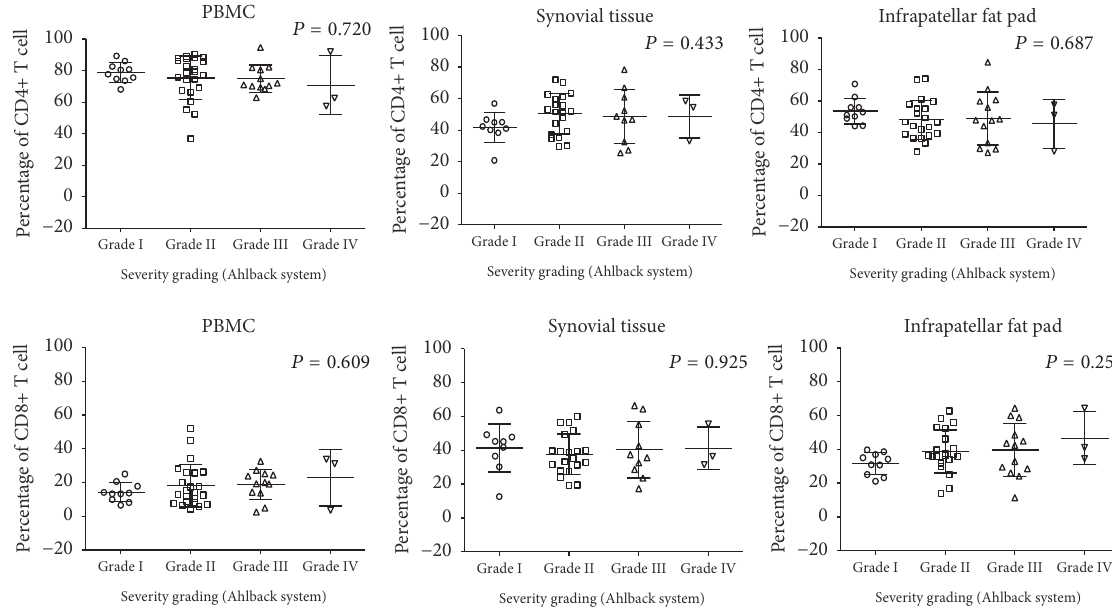
Figure 2: Frequency of CD4 + and CD8 + T cells from peripheral blood, synovial tissue, and infrapatellar fat pad in patients with higher radiographic grading. Graphs showing frequencies of CD4 + and CD8 + T cells in peripheral blood (PBMC) ( 𝑁 = 48 ), synovial tissue (ST) ( 𝑁 = 42 ), and infrapatellar fat pad (FP) ( 𝑁 = 47 ) from patients which were clinically graded based on the Ahlback classification system into grades I to IV. Number of dots corresponds to number of the patients. Error bar represents the mean and standard deviation (mean ±